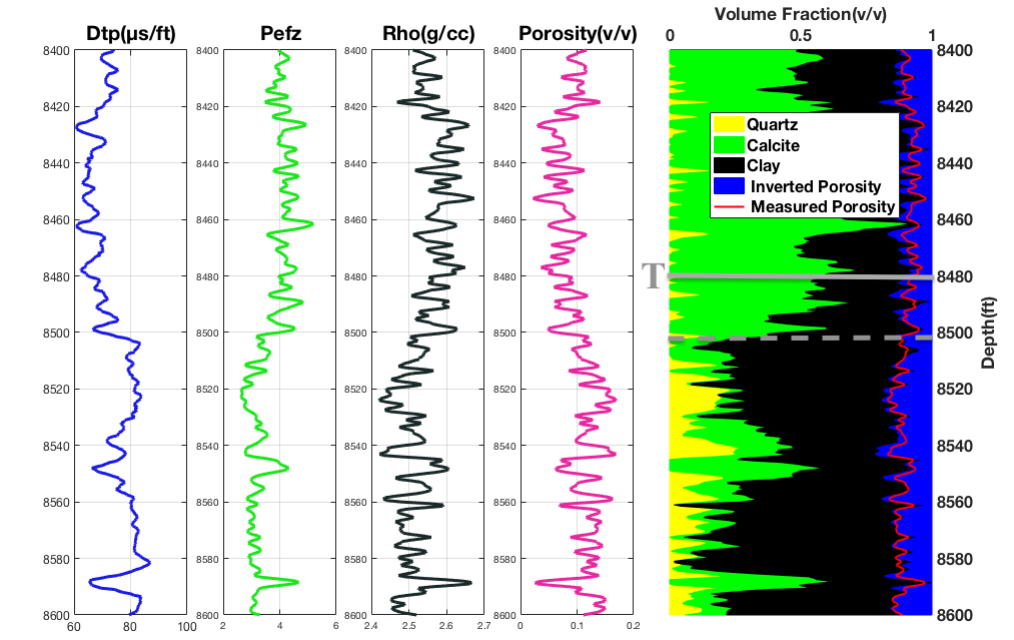
Figure 4. Composition analysis of geophysical well logs, Permian Basin, West Texas, calculated using the least-squares method. A good match can be observed between the inverted and measured porosity (neutron porosity). T marks the corresponding location of thin section photomicrograph in Figure 6. The broken line represents a division between the quartz rich zone and the calcite rich